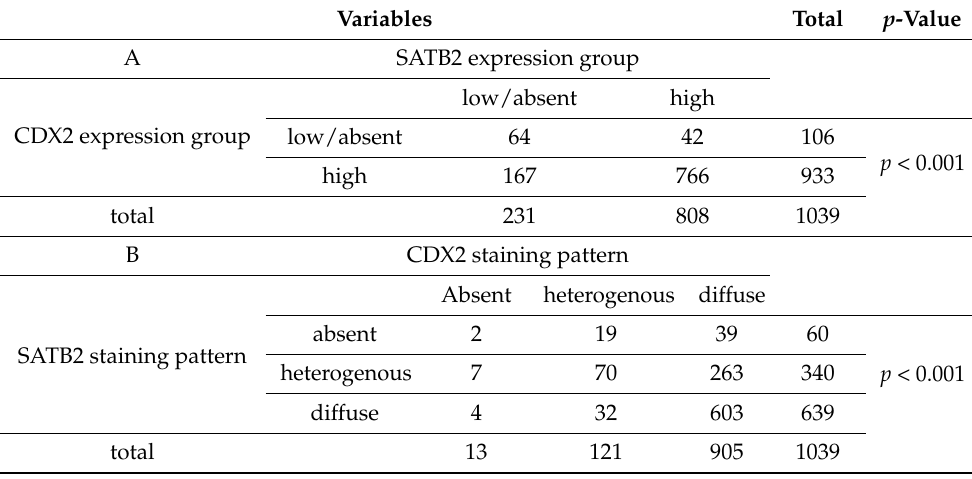
Table 2. Correlation of SATB2 and CDX2 expression groups and CDX2/SATB2 staining patterns.